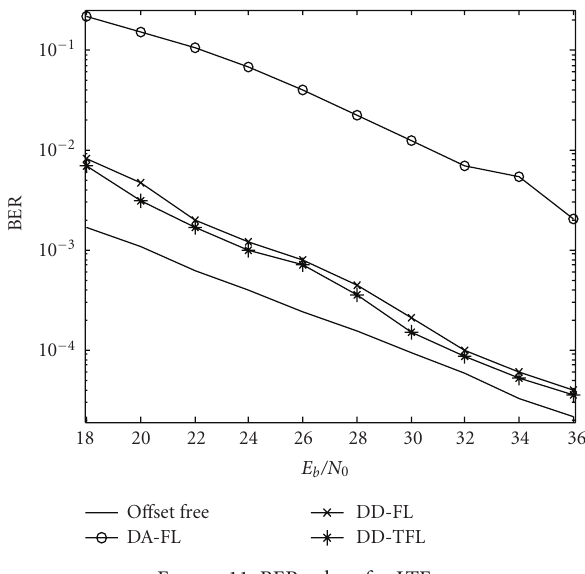
Figure 11: BER values for LTE.